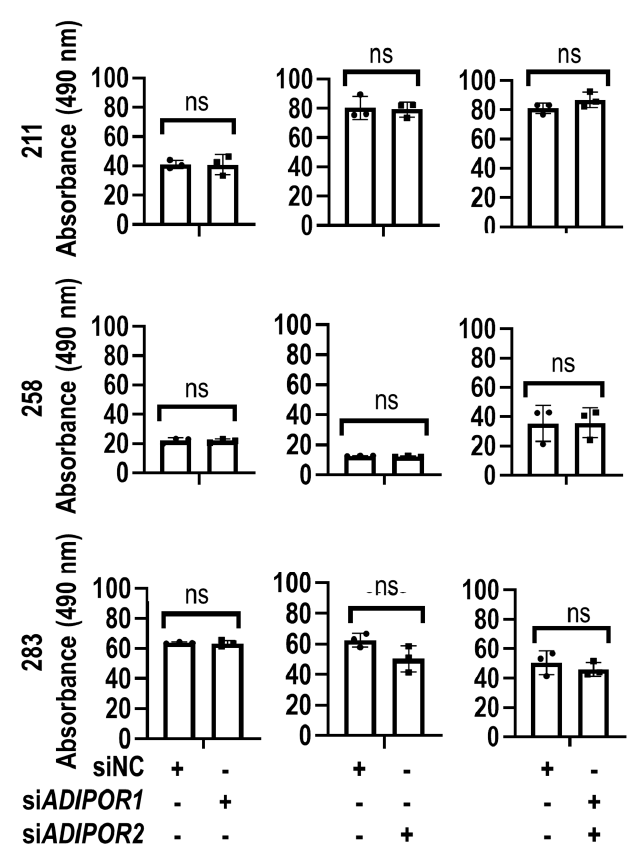
Figure 4. Metabolic activity is preserved in MSCs lacking ADIPOR1 and ADIPOR2 expression. Cellular metabolic activity was assessed by MTS assay in MSCs derived from three donors (211, 258 and 283), transfected with (siNC), or siRNAs for ADIPOR1 (si ADIPOR1 ), ADIPOR2 (si ADIPOR2 ) or the combination of ADIPOR1 and ADIPOR2 (si ADIPOR1 +si ADIPOR2 ). Statistical difference in gene expression between groups is shown with brackets. Asterisks indicate differences in probability values: p > 0.05 = not significant (ns). Statistical significance and error bars (mean ± standard deviation) are based on n = 3 biological replicates for each of the three MSC donors (data points superimposed on the graphs).